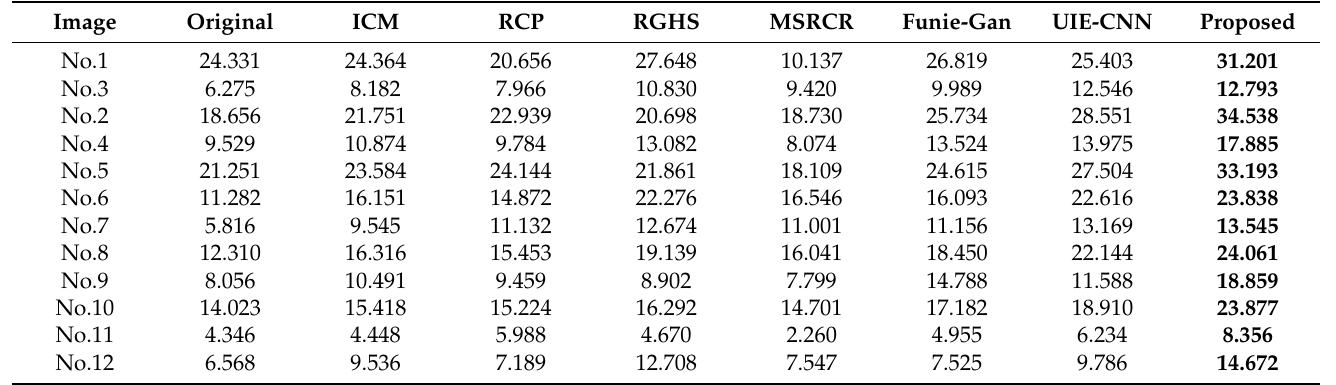
Table 4. Evaluation of processed images by the metric of average gradient.